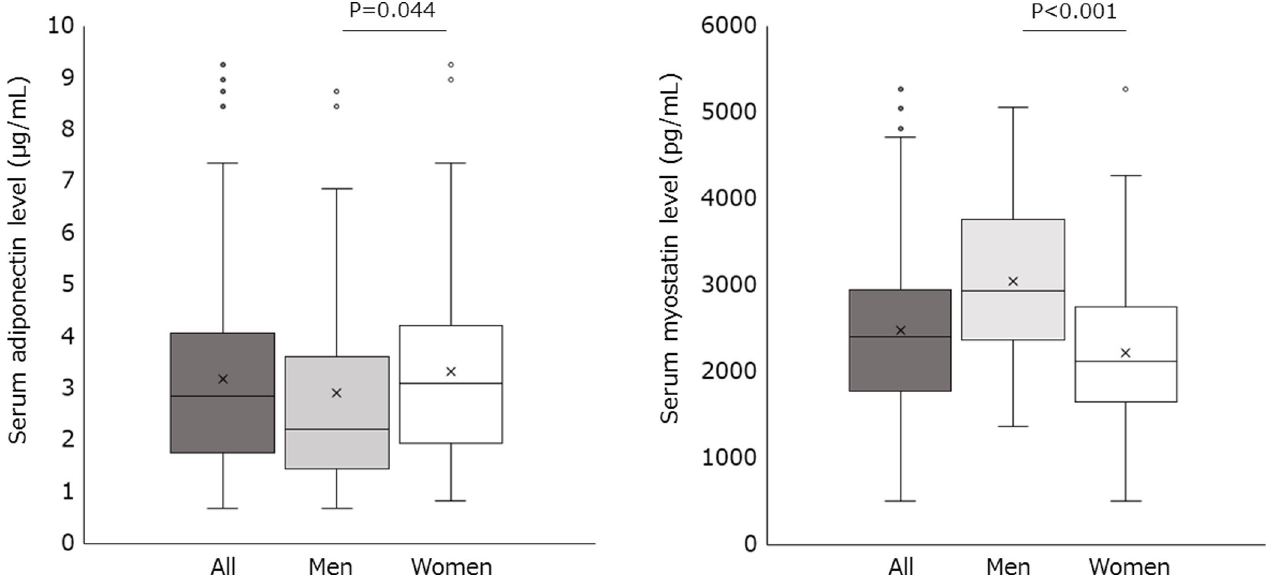
Fig 1. Serum adiponectin and myostatin levels in patients with obesity. In these plots, lines within the boxes represent median values; the upper and lower lines of the boxes represent 25 th and 75 th percentiles, respectively; and the upper and lower bars outside the boxes represent the 90 th and 10 th percentiles,